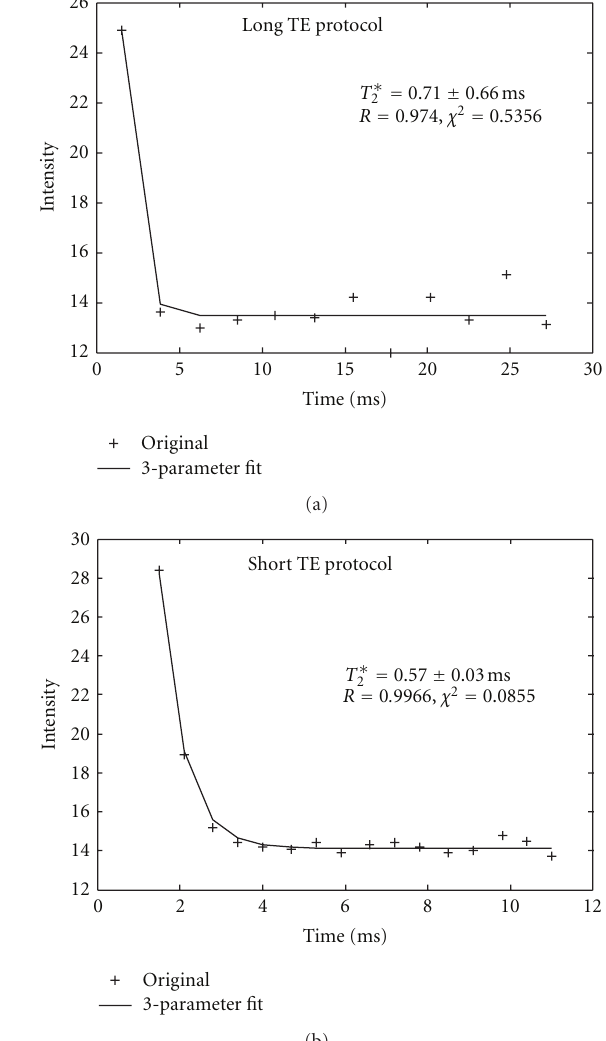
Figure 2: Results of T ∗ 2 curve fit from a patient with short T ∗ 2 values by dual acquisition method (Figure 1(a)). Data was acquired by the long TE protocol (Figure 1(b)). The same patient data was acquired by the short TE protocol, there were more data points in the curvature area. It is obvious that data acquired by short TE protocol generated better fit for short T ∗ 2